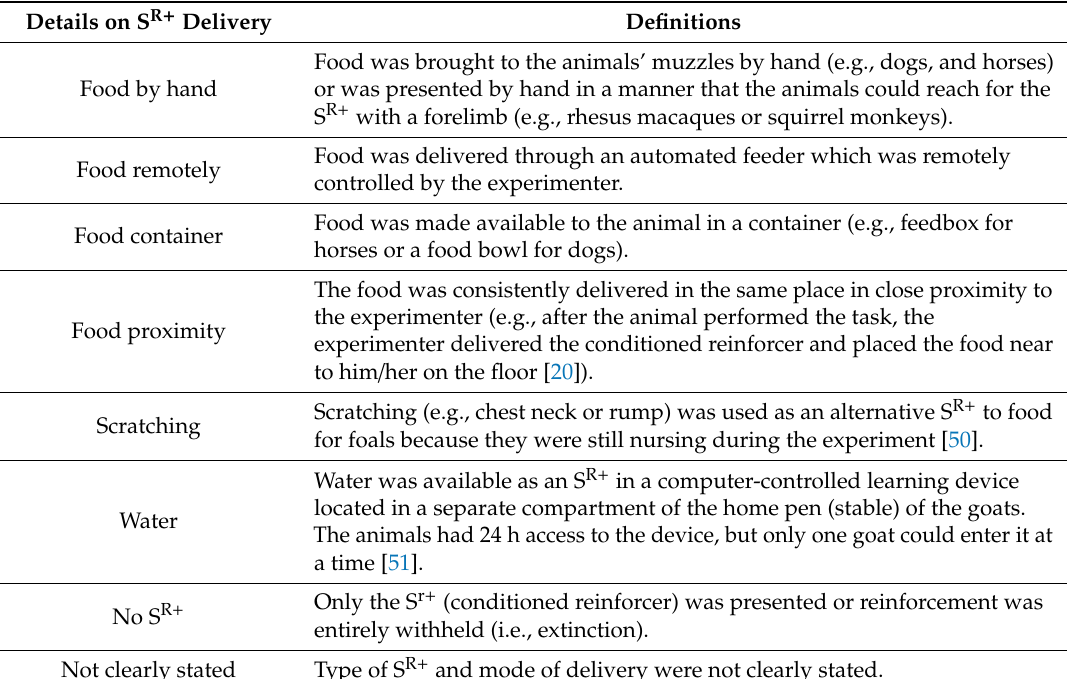
Table 1. Details on the delivery of the S R + and respective definitions as reported in the eligible studies. Details on S R +